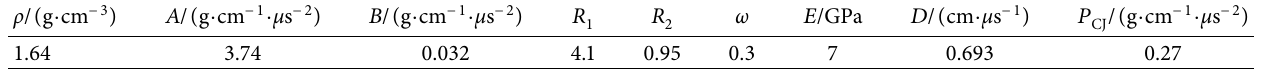
Table 1: Material parameters of explosive.